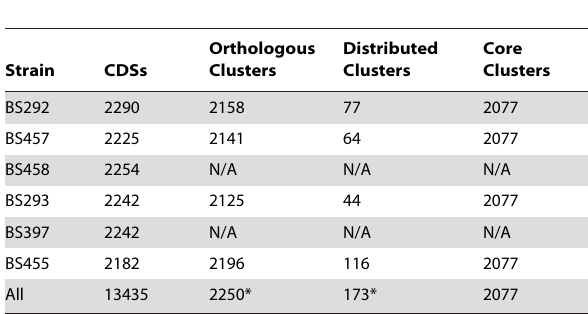
Table 2. Summary of CDSs and their organization into orthologous